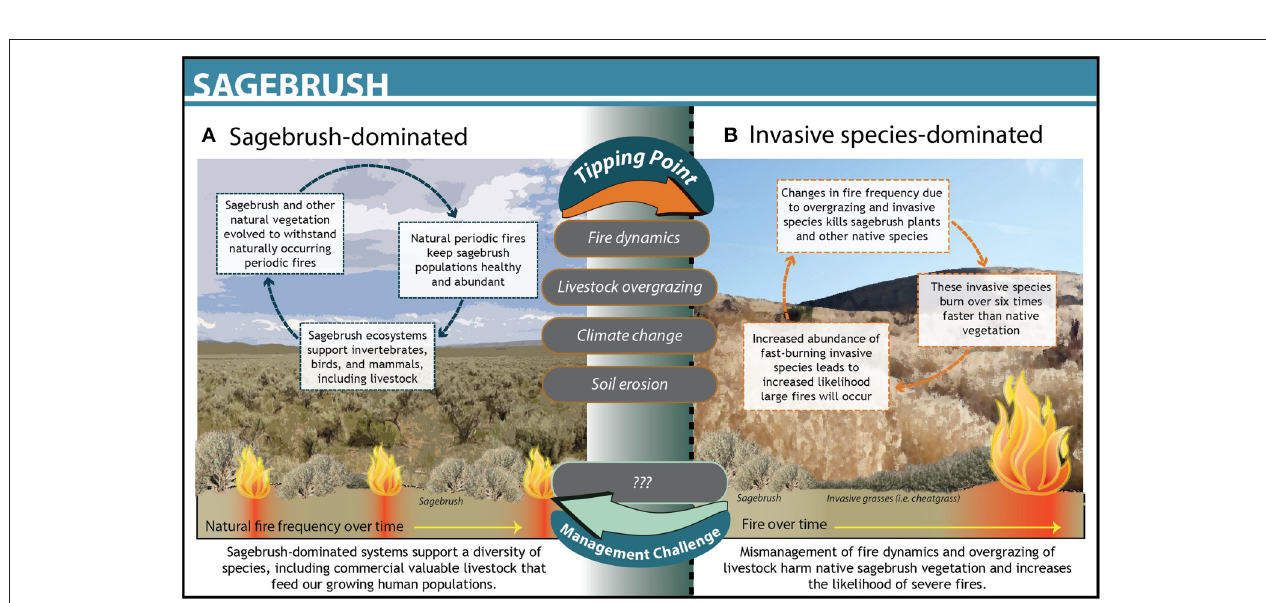
FIGURE 2 | The dynamics and structure of Florida Bay before (A) and after (B) crossing a threshold. The upper gray text bubbles between states denote drivers that pushed the system across a threshold and lower bubbles denote management action taken that restored the systems to its previous state.